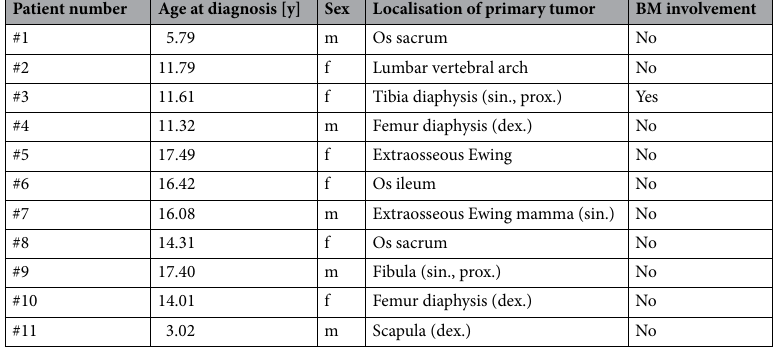
Table 2. Patient cohort of 11 uniformely treated pediatric patients with newly diagnosed Ewing sarcoma. y, years; m, male; f, female; sin., sinister; dex., dexter; prox., proximal.